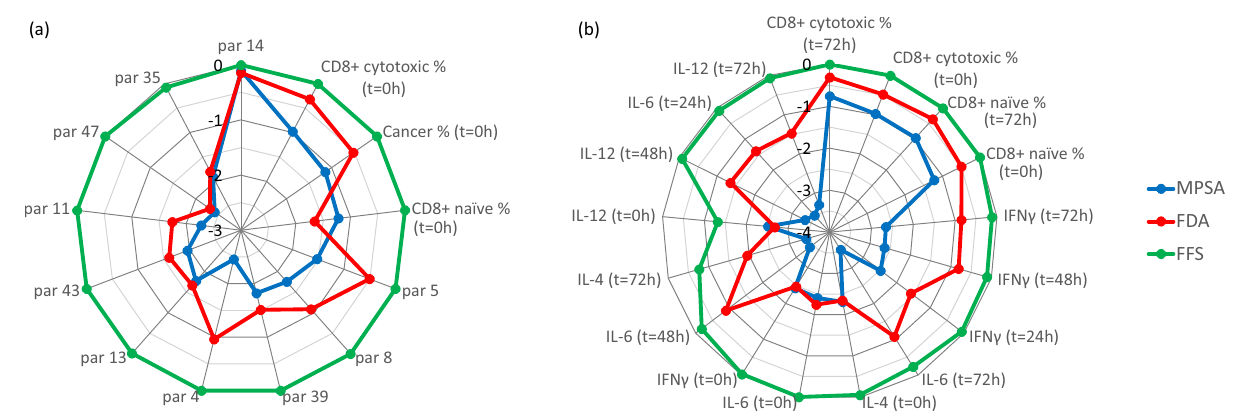
Fig. 2 Distribution of feature selection scores from the MPSA method, Fisher discriminant analysis (FDA), and fi lter feature selection (FFS). a tumor micro-environment features and ( b ) experimentally accessible response features. Plots depict log 10 ½ MPSA sensitivity (cid:2) , log 10 ½ standardized canonical coefficient (cid:2) from FDA, and log 10 [1 − p -value] obtained from two-sample t -test during FFS. In ( a ) systems biology kinetic parameter numbers are indicated by “ par ” .